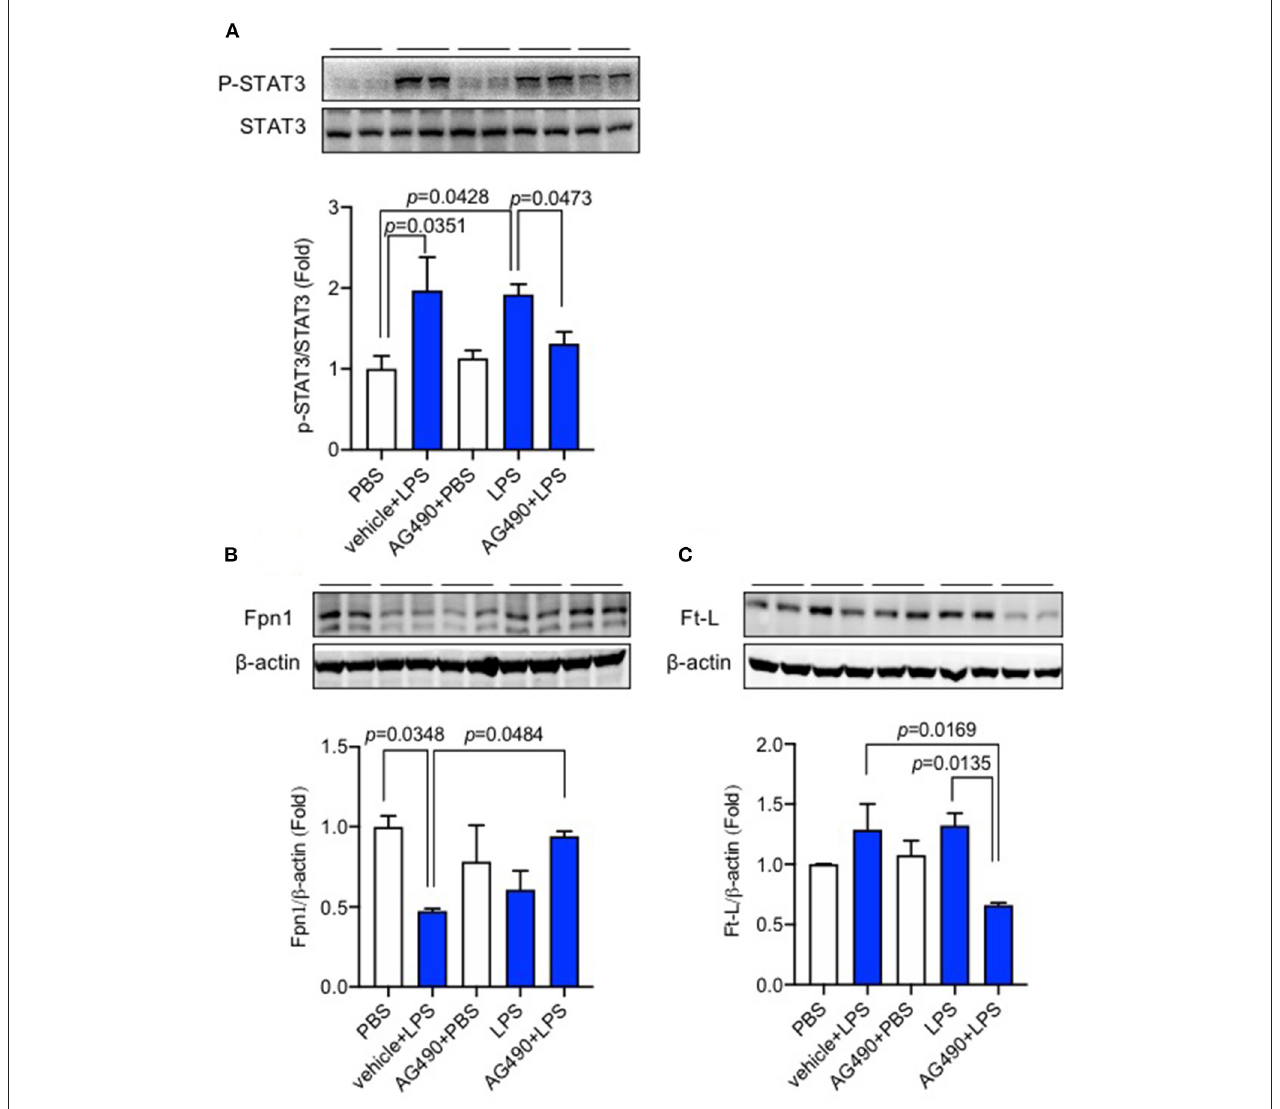
FIGURE 4 | AG490 significantly reduced p-STAT3 protein expression and eliminated the changes in Fpn1 and Ft-L expression induced by lipopolysaccharide (LPS) in the liver. C57BL/6 wild-type male mice were pre-treated with AG490 (5 mg/kg, IP injection) in 10% dimethyl sulfoxide (DMSO) or vehicle 30min before LPS (ICV injection, 5 µ g in 2 µ L of sterile saline). The expression levels of p-STAT3 (A) , Fpn1 (B) , and Ft-L proteins (C) in the liver were measured using western blot. Data are presented as means ± SEM (% control) ( n = 4). For statistical analysis, one-way ANOVA with Tukey’s post hoc test was